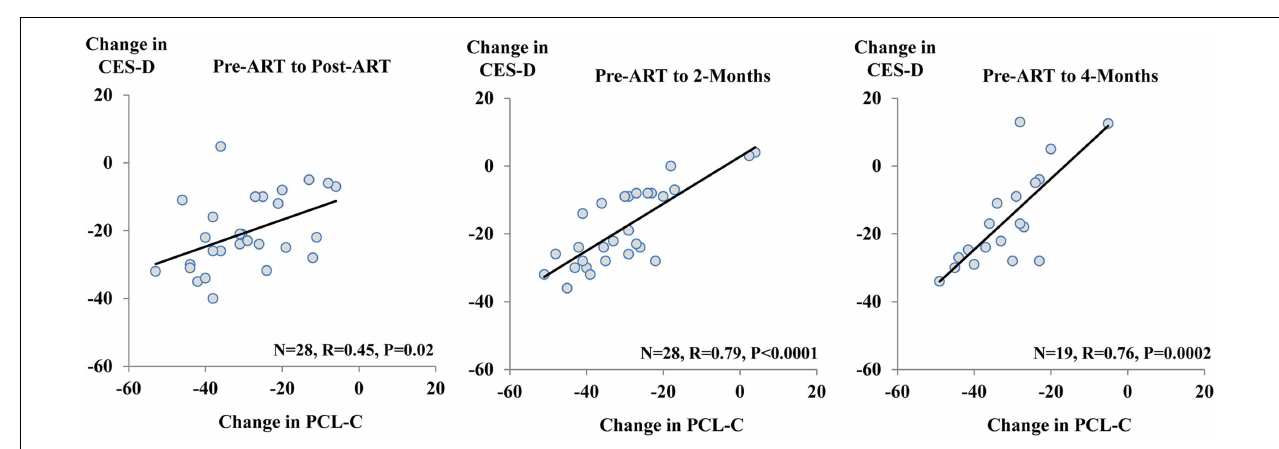
FIGURE 2 | Distribution of self-report scores on the 17-item PCL-C (left side: possible range of 17–85) and 20-item CES-D (right side: possible range of 0–60) at baseline, post-treatment, and 2- and